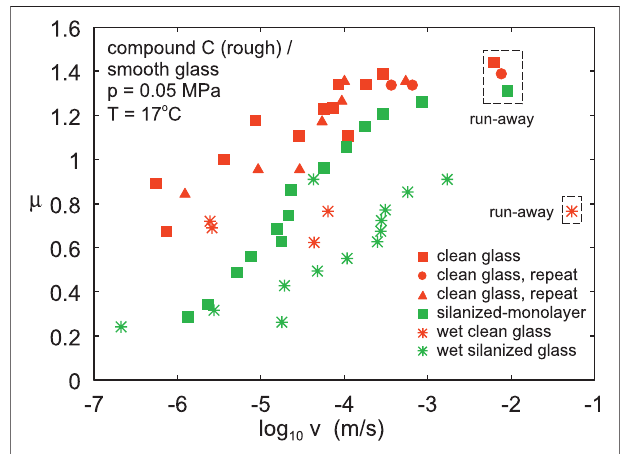
FIGURE 10 | Rubber-glass asperity contact regions in water. At short enough length scale the contact pressure becomes so high that the contact area (locally) percolate. When the contact is formed in water, pressurized watermayoccurinthesealed-offregions.Inthiscasepartoftheexternal load will be carried by the water resulting in a reduced rubber-glass contact area and a reduced sliding